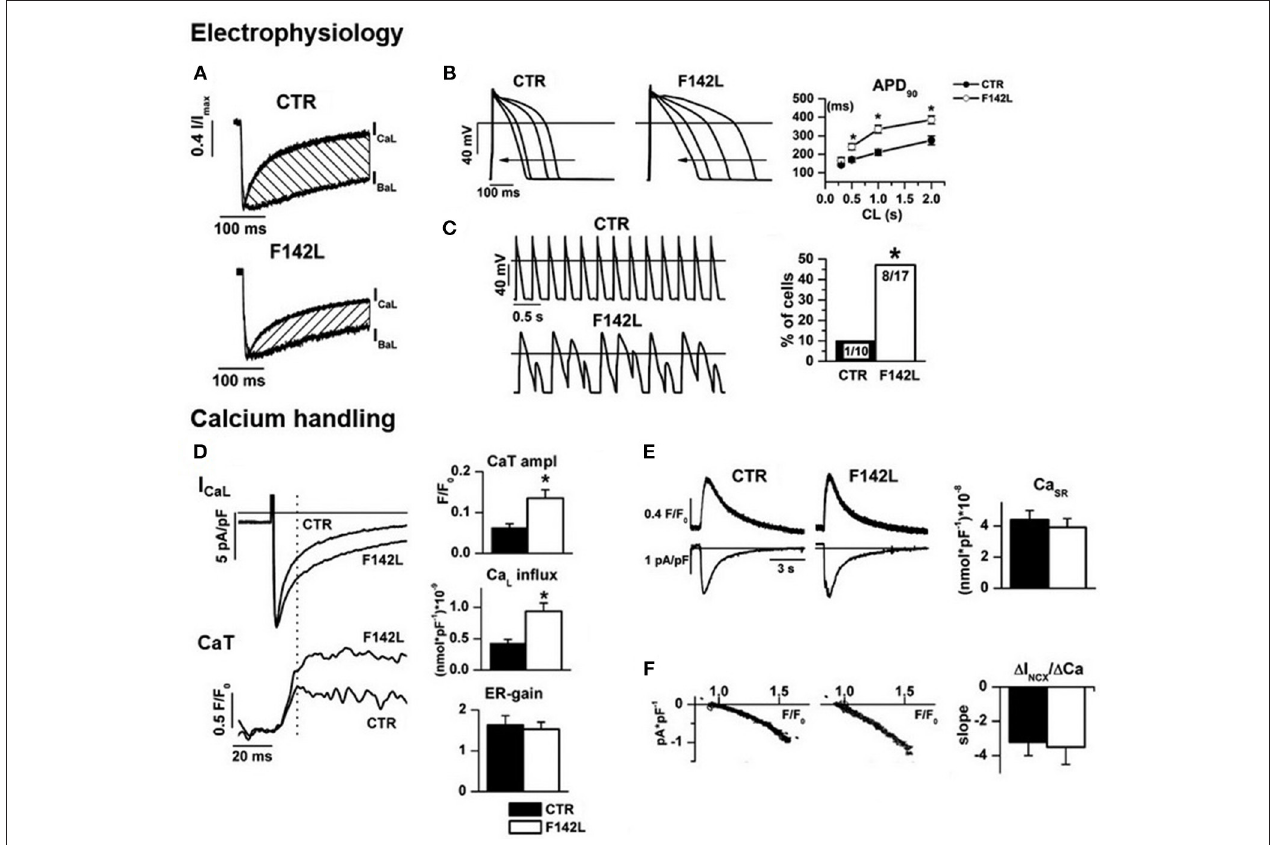
FIGURE 4 | Arrhythmogenic mechanism of CALM1 F142L from experiments in patient-derived hiPSC-CMs. Electrophysiology: (A) I CaL CDI (hatched area) was reduced; (B) CDI impairment led to APD prolongation and inadequate APD shortening at high pacing rate; (C) APD abnormalities led to loss of 1:1 response to fast pacing in a large % of F142L cells. Calcium handling : (D) Impaired I CaL CDI led to matching increments of Ca 2 + influx and of the amplitude of Ca 2 + transients (CaT); excitation/release gain (ER-gain) was unchanged, thus suggesting normal RyRs function. (E) In spite of enhanced Ca 2 + influx, SR Ca 2 + content was unchanged, thus implying compensation by homeostatic mechanisms. (F) The slope of the relationship between Na + /Ca 2 + exchanger current (I NCX ) and Ca 2 + concentration was unchanged, to indicate that homeostatic compensation did not involve changes in the expression of the exchanger. Asterisks denote significance of changes. Modified from ref. Rocchetti et al.